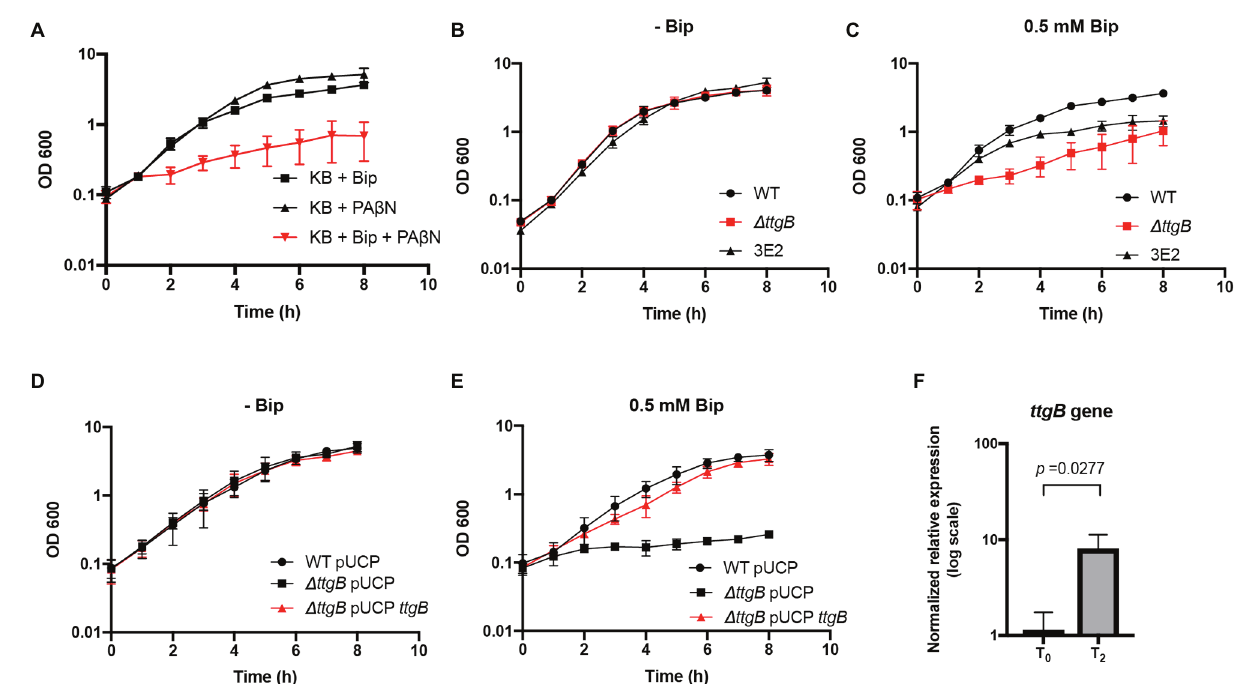
FIGURE 1 | A functional TtgABC is required for bipyridyl (Bip) detoxification in Pseudonomas putida KT2440 in presence of Bip. (A) Growth of the wild type was analyzed in King’s Broth (KB) medium supplemented with 0.5 mM Bip, 20 μ g/ml Phe-Arg- β -naphthylamide (PA β N), or the combination of both. (B) Growth was assessed for wild type, ttgB mutant and 3E2 strain (non-producer for pyoverdine) in KB medium without supplementation and (C) in presence of 0.5 mM Bip. (D) Growth of wild type and ttgB mutant transformed with pUCP or pUCP- ttgB for complementation was recorded in KB medium plus 1 mg/ml ampicillin without supplementation or (E) in presence of 0.5 mM Bip and 1 mM IPTG. For (A–E) , washed cells from an overnight culture were resuspended in water and used to inoculate 35 ml of KB medium supplemented with the corresponding compound (initial OD600 of 0.1). The flasks were incubated at 30 ° C with continuous shaking (180 rpm). OD600 was measured at given time points. (F) Relative expression levels for ttgB in presence of KB plus Bip in comparison to KB without supplementation (wild type strain). For this experiment, after 2 h of growth at 30 ° C with continuous shaking (T 0 ), Bip was added to the medium, and another incubation was performed for 90 min (T 2 ). RNA samples were taken at T 0 and T 2 and compared by qRT-PCR using rpoD as reference gene. The data are presented as an average of three independent